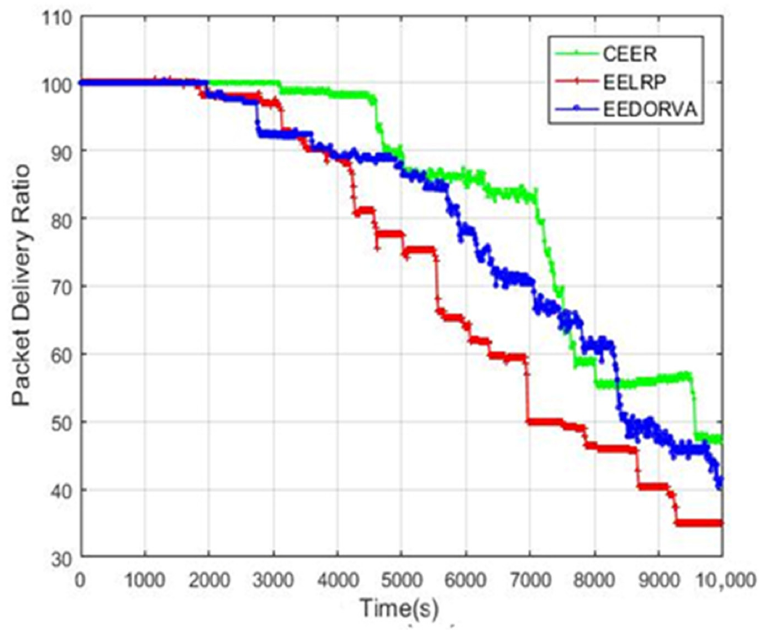
Figure 6. PDR of the routing scheme.